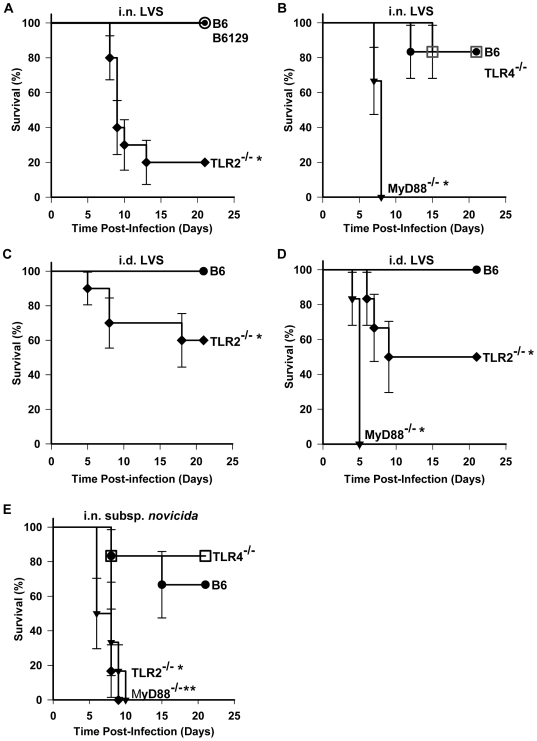
Survival of TLR−/− and MyD88−/− mice inoculated intranasally or intradermally with F. tularensis.Groups of mice (•, B6; ○, B6129PF2/J; ♦, TLR2−/−; □, TLR4−/−; ▾,MyD88−/−) were inoculated i.n. or i.d. with the indicated strains. The mice were monitored daily for 21 days for survival and signs of illness. Kaplan-Meier survival analyses were performed and survival was plotted as a function of time with each point representing the cumulative probability of survival for the indicated group. Error bars represent the standard error for the cumulative probability of survival. Significant differences among groups were determined by Log Rank analysis and individual p values were calculated by the Holm-Sidek method as described in Materials and Methods; p values of <0.05 were considered significant. (A) The i.n. inoculum for B6 and TLR2−/− mice was 4,330 CFU of LVS; i.n. inoculum for B6129PF2/J mice was 6,183 CFU; n = 10. One representative experiment is shown of two independent experiments performed. *p = 0.001. (B) The i.n. inoculum was 5,360 CFU of LVS, n = 6. One representative experiment is shown of 2–4 independent experiments performed. *p = 0.001. (C) The i.d. inoculum was 38,680 CFU of LVS, n = 10. *p = 0.029. (D) The i.d. inoculum was 45,600 CFU, n = 6. *p = 0.055; **p = 0.001. (E) The i.n. inoculum was 4 CFU of F. tularensis subsp. novicida, n = 6. *p = 0.004; **p = 0.004.